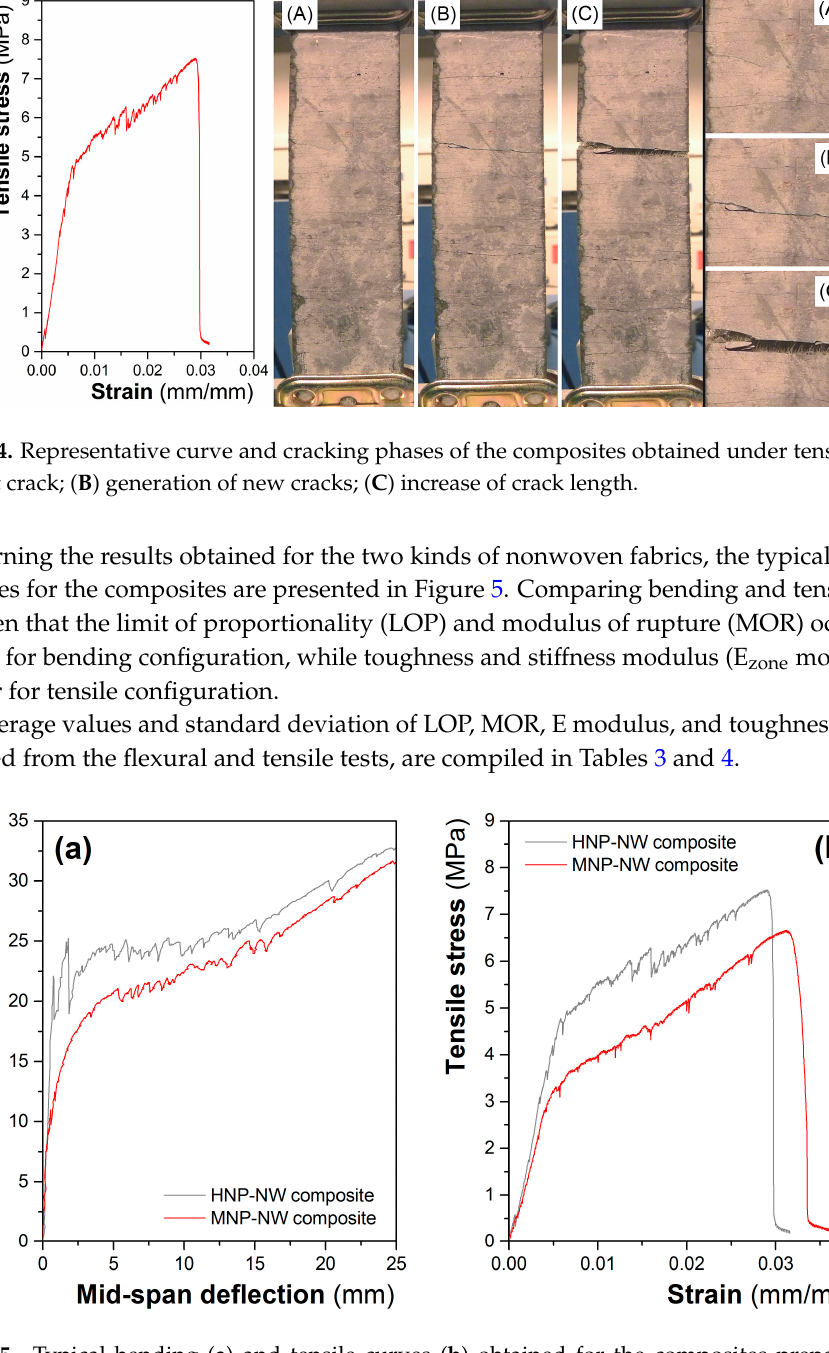
Figure 3. Representative curve and cracking phases of the composites obtained under flexural stress: ( A ) first crack; ( B ) generation of new cracks; ( C ) increase of crack length.